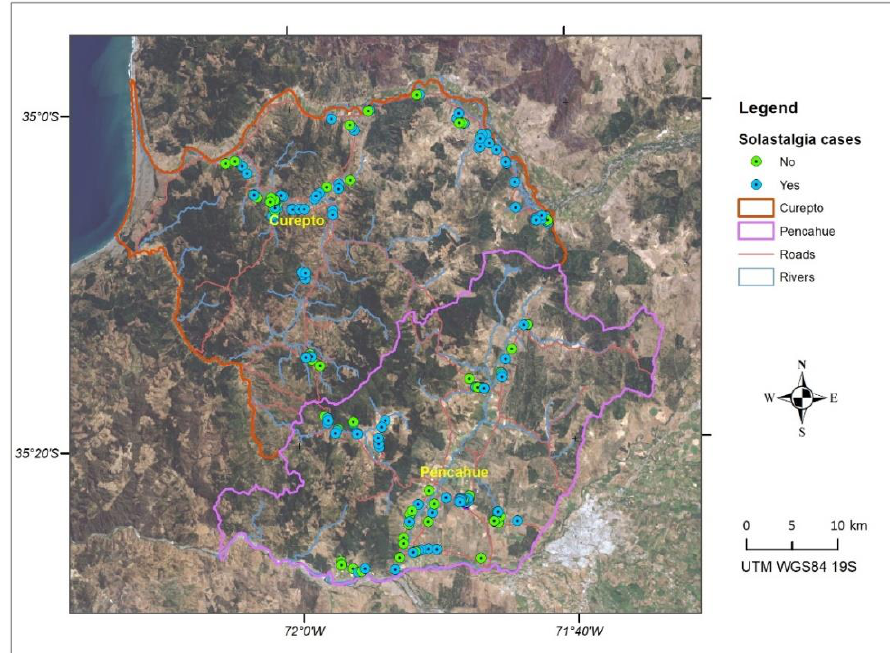
Figure 4. Spatial distribution of solastalgia cases.